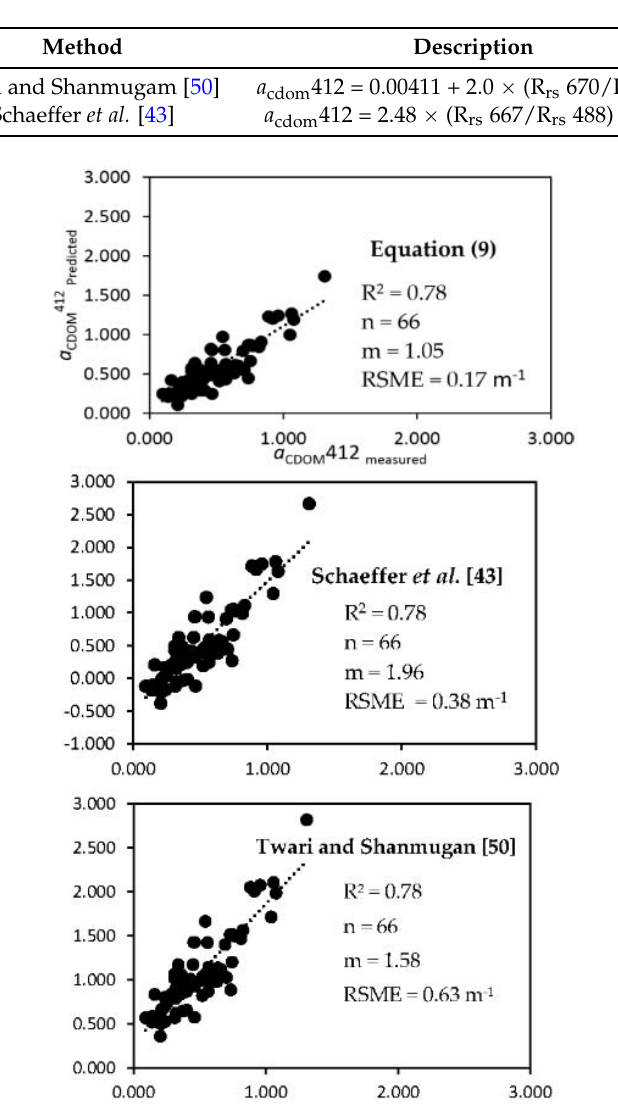
Table 4. Algorithms used to compare a cdom 412 derived from Equation (4) and from the published.